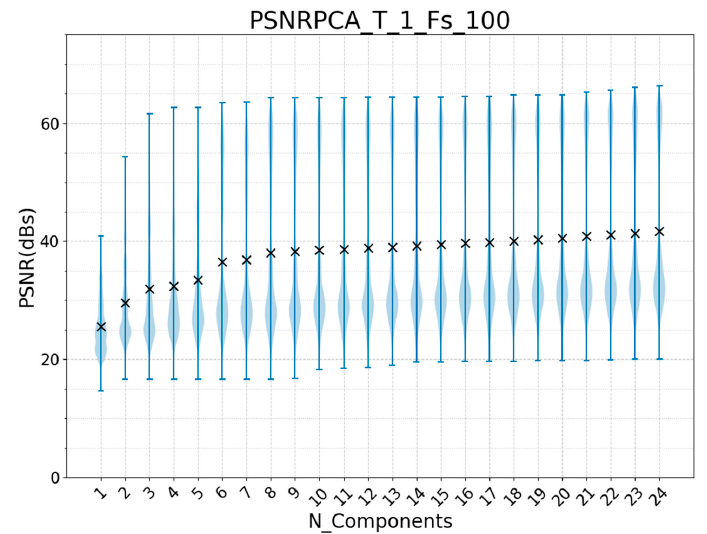
Figure 14. PSNR distribution and mean value (x) vs. number of components for PCA .